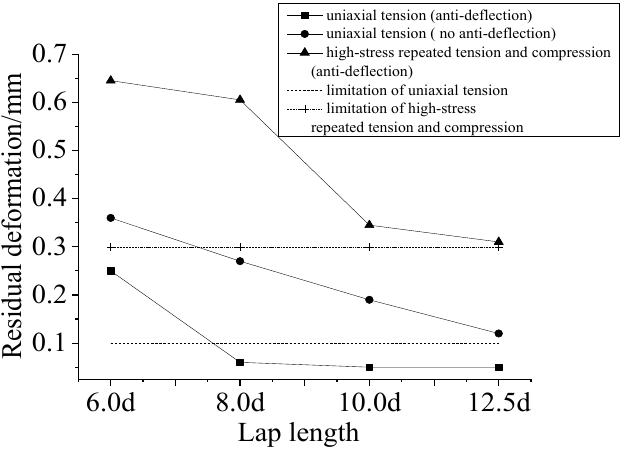
Figure 17. Relationship between residual deformation and lapping length under uniaxial tension and high-stress repeated tension and compression loading.